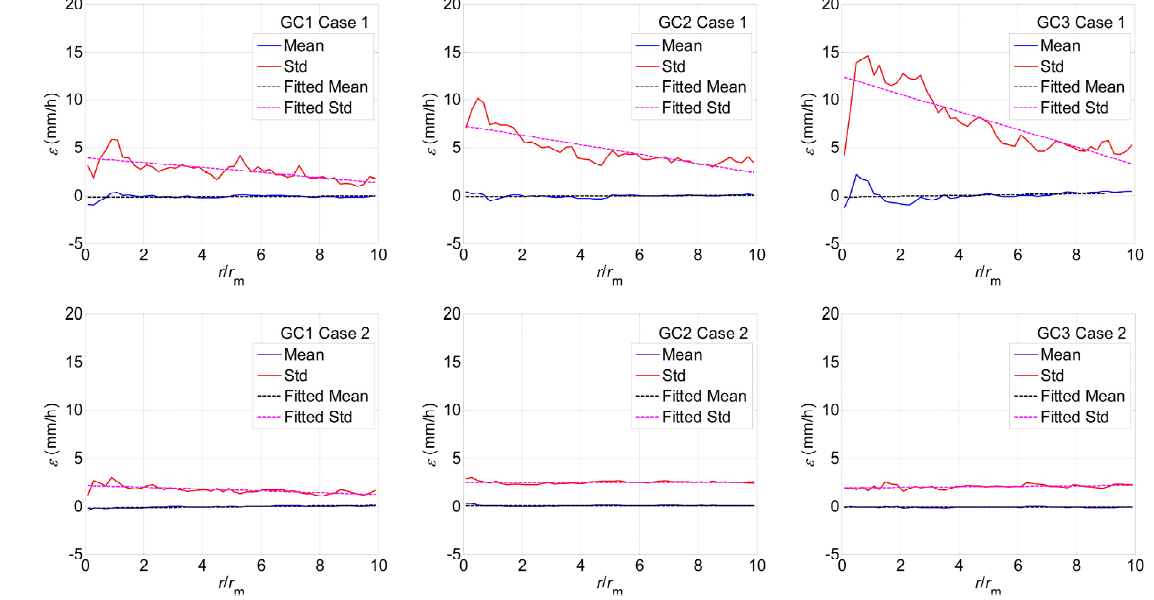
Figure 8. Mean and standard deviation of residual ε ( r / r m ). Table 3. Parameters for the statistics of the